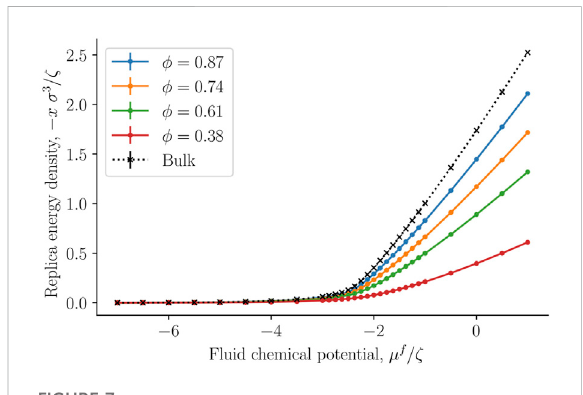
FIGURE 9 Trace of the mechanical pressure divided by three as